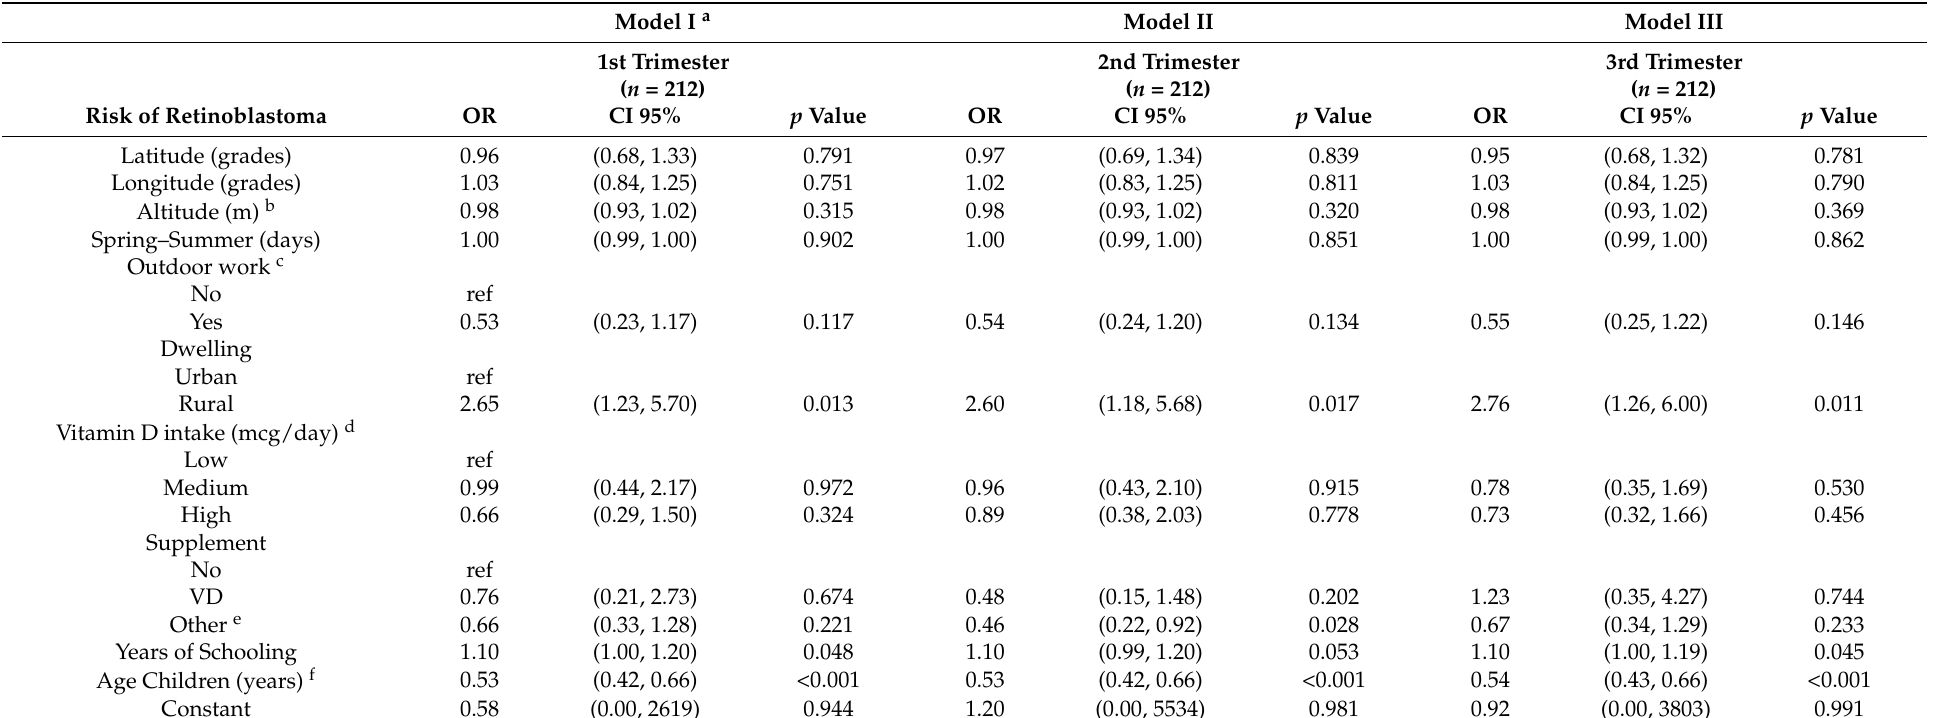
Table 4. Association between DF and PF during pregnancy and SRb in offspring in